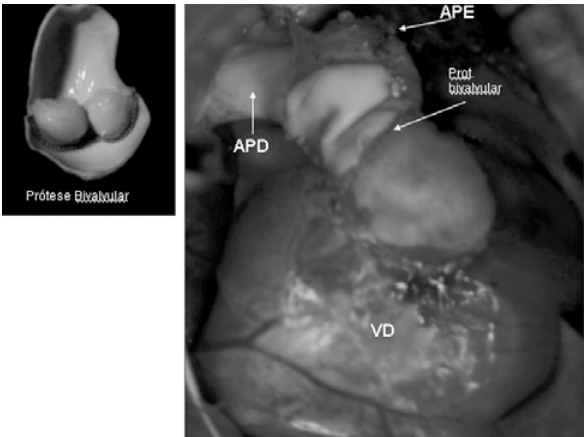
Fig. 6 - Fotografia cirúrgica. Reconstrução da junção ventrículo direito (VD) - artéria pulmonar (AP), com prótese bivalvular (Prot. bivalvular) pulmonar suína